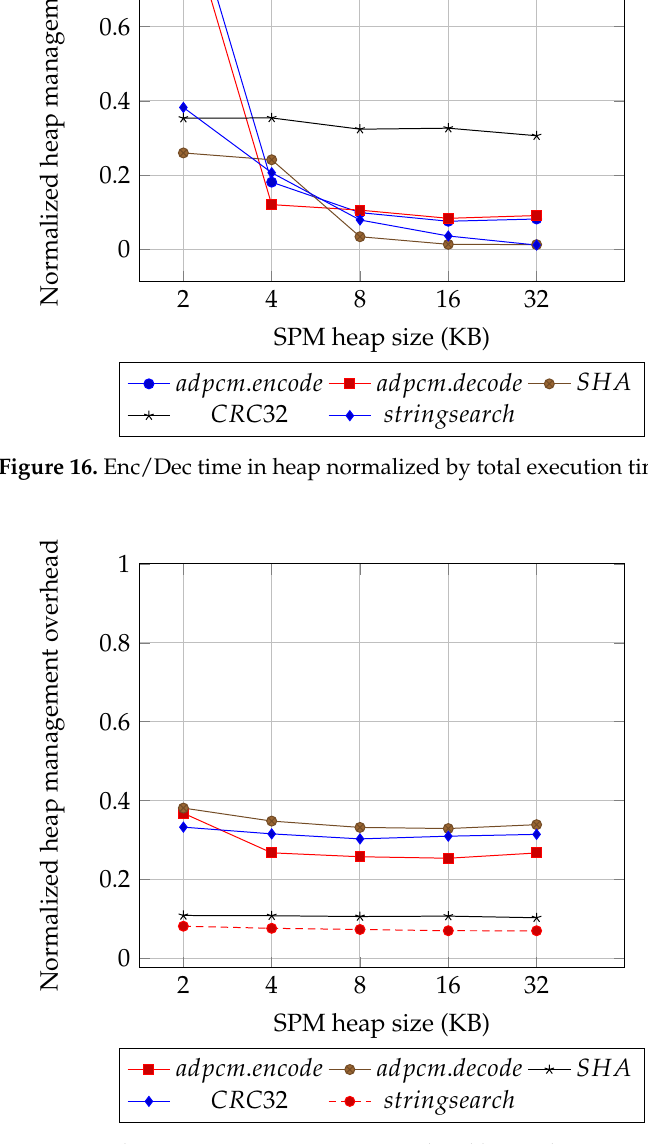
Figure 17. SPM heap management time normalized by total execution